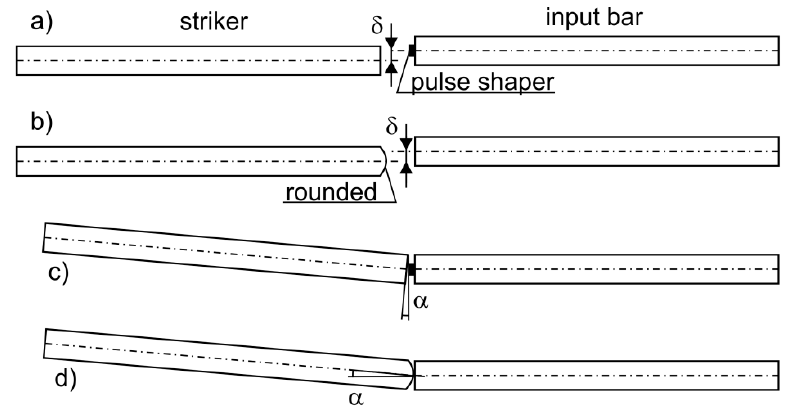
Figure 2. Striker and bar misalignment; neutral axis offset δ (a), striker hitting the input bar at inclination angle α (b), (a), and (c) with use of the pulse shaper; (b) and (d) – with rounded striker.